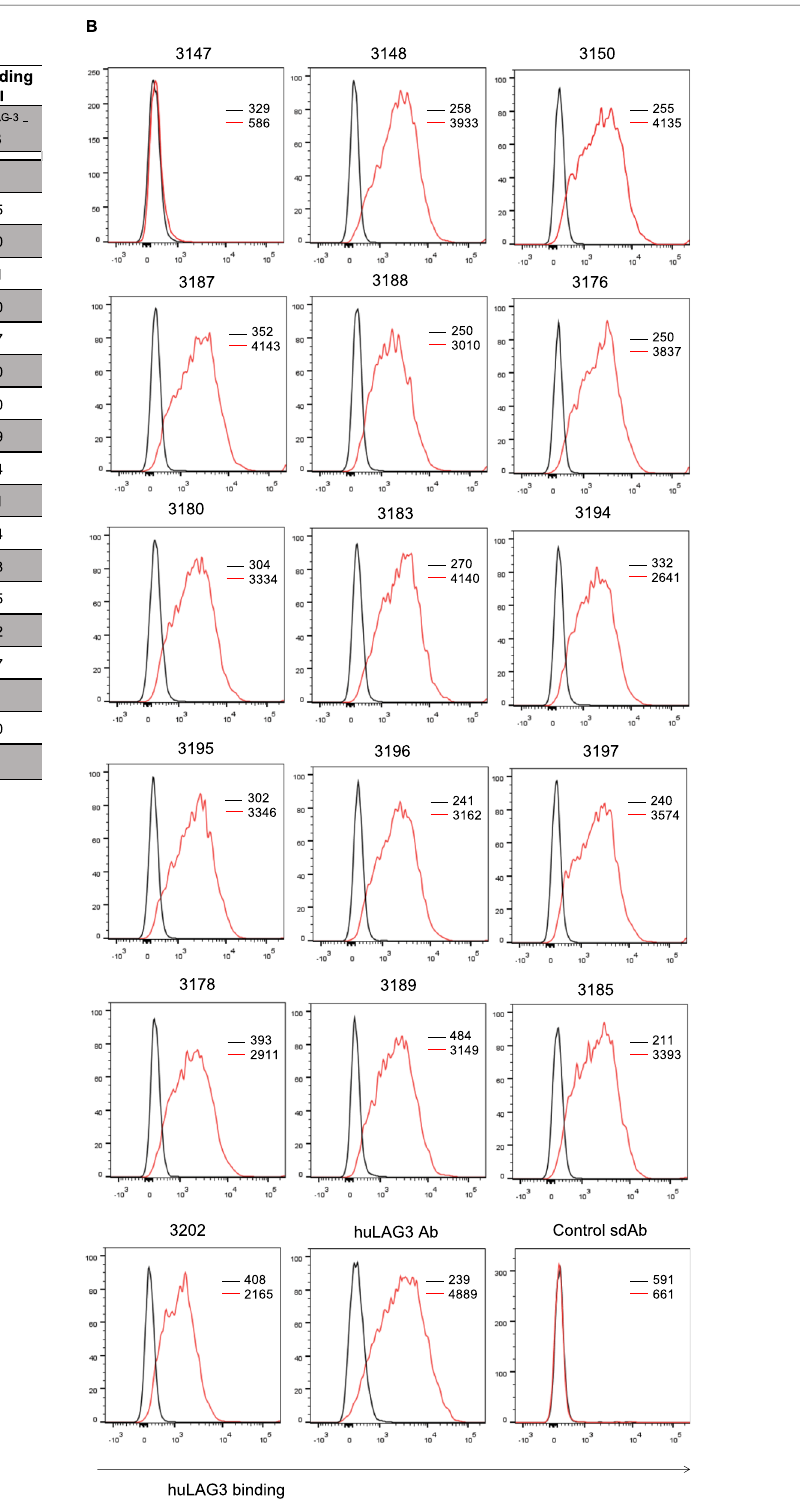
Fig. 2 Binding characteristics of selected anti-LAG-3 sdAbs on huLAG-3 expressing 2D3 cells. A The table shows the code, sequence family and the binding of the sdAb to 2D3 cells versus 2D3-huLAG-3 cells, calculated using the MFI determined in flow cytometry. B Histogram showing binding of anti-huLAG-3 sdAbs on 2D3 (black line) or 2D3-huLAG-3 (red line) cells, measured using flow cytometry ( n